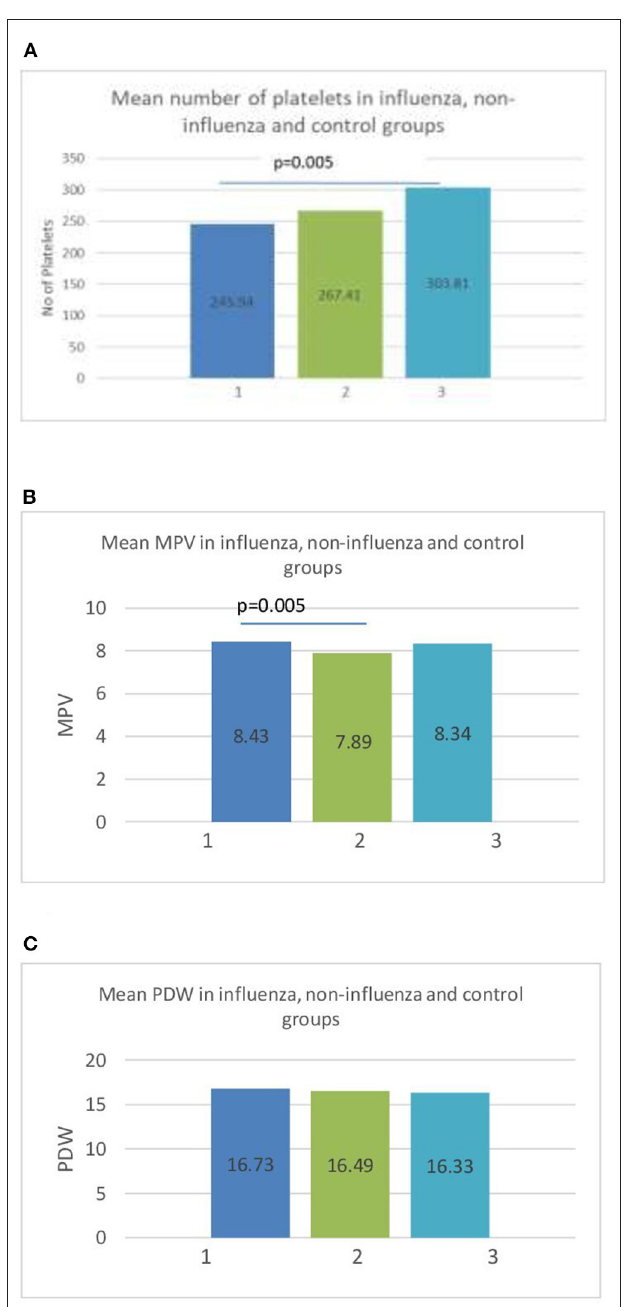
FIGURE 1 | (A) Mean number of platelets (PLT) in influenza (1), non-influenza (2), and control (3) groups. (B) Mean value of mean platelet volume (MPV) in influenza (1), non-influenza (2), and control (3) groups. (C) Mean platelet distribution width (PDW) in influenza (1), non-influenza (2) and control (3) groups.